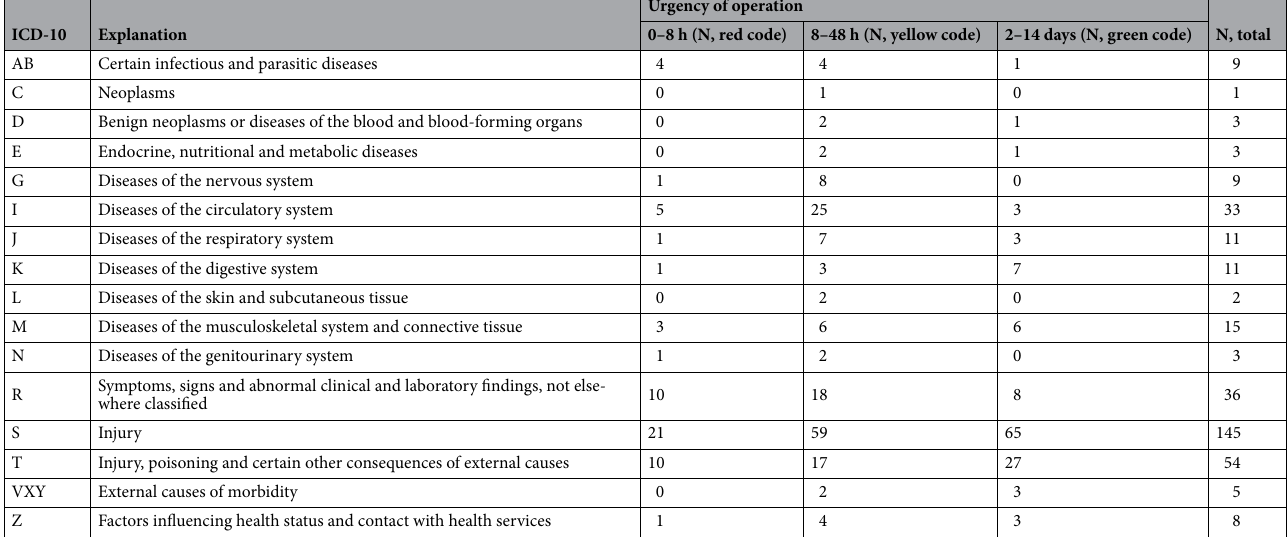
Table 3. Causes of postoperative visits in emergency department within 30